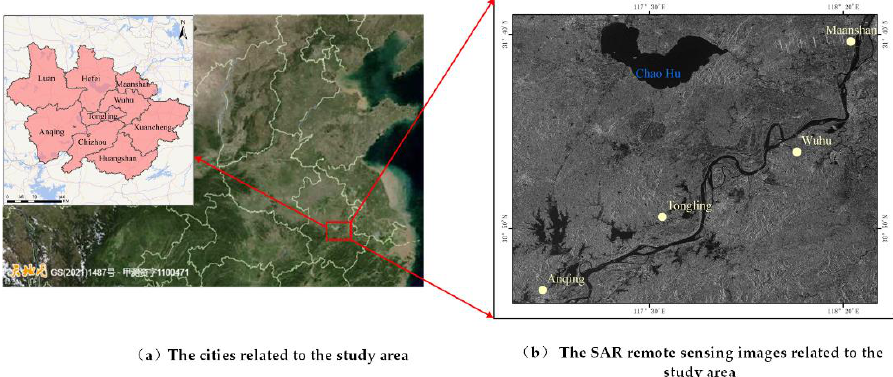
Figure 1. The study area shown in this paper. Among them, ( a ) depicts the cities involved in the study area; ( b ) shows the SAR remote sensing image covering the study area.